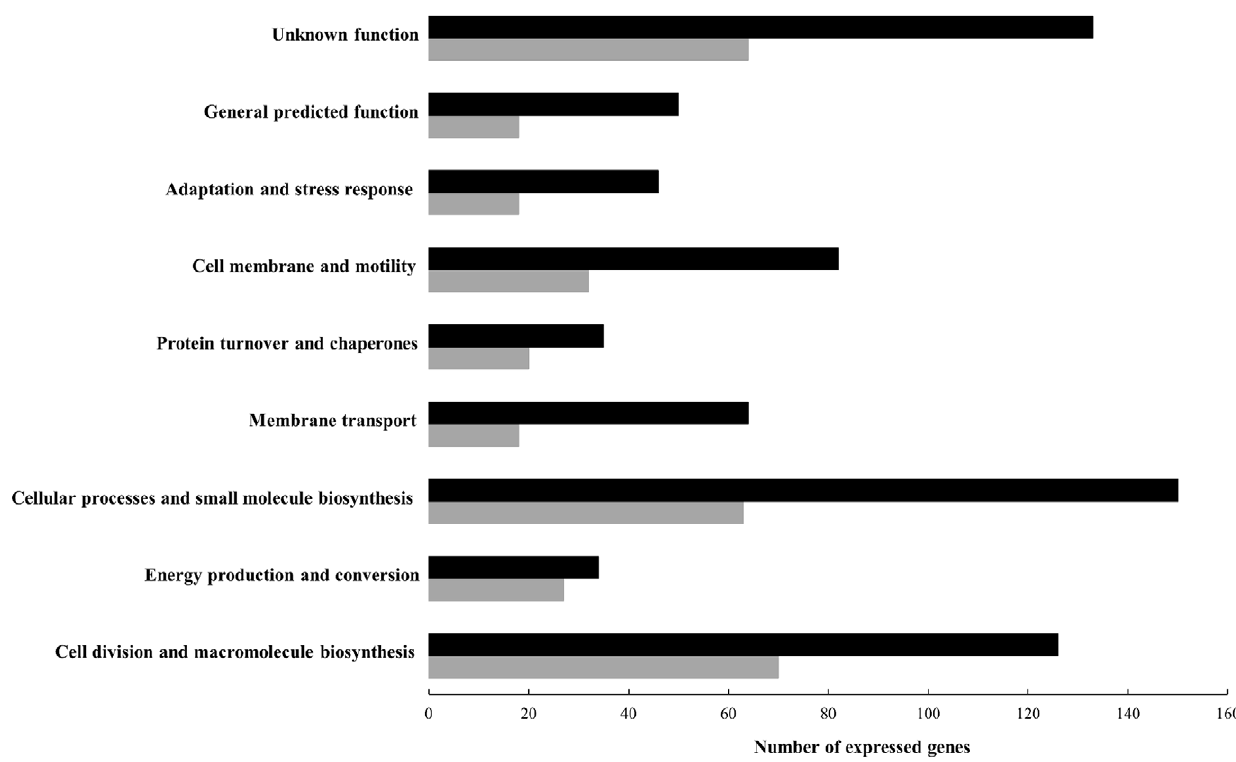
Figure 2. Functional categories of genes expressed by the pathogenic and non-pathogenic homologous L.intracellularis isolate PHE/ MN1-00. Black and gray bars represent the number of genes expressed by the pathogenic and non-pathogenic variants, respectively.